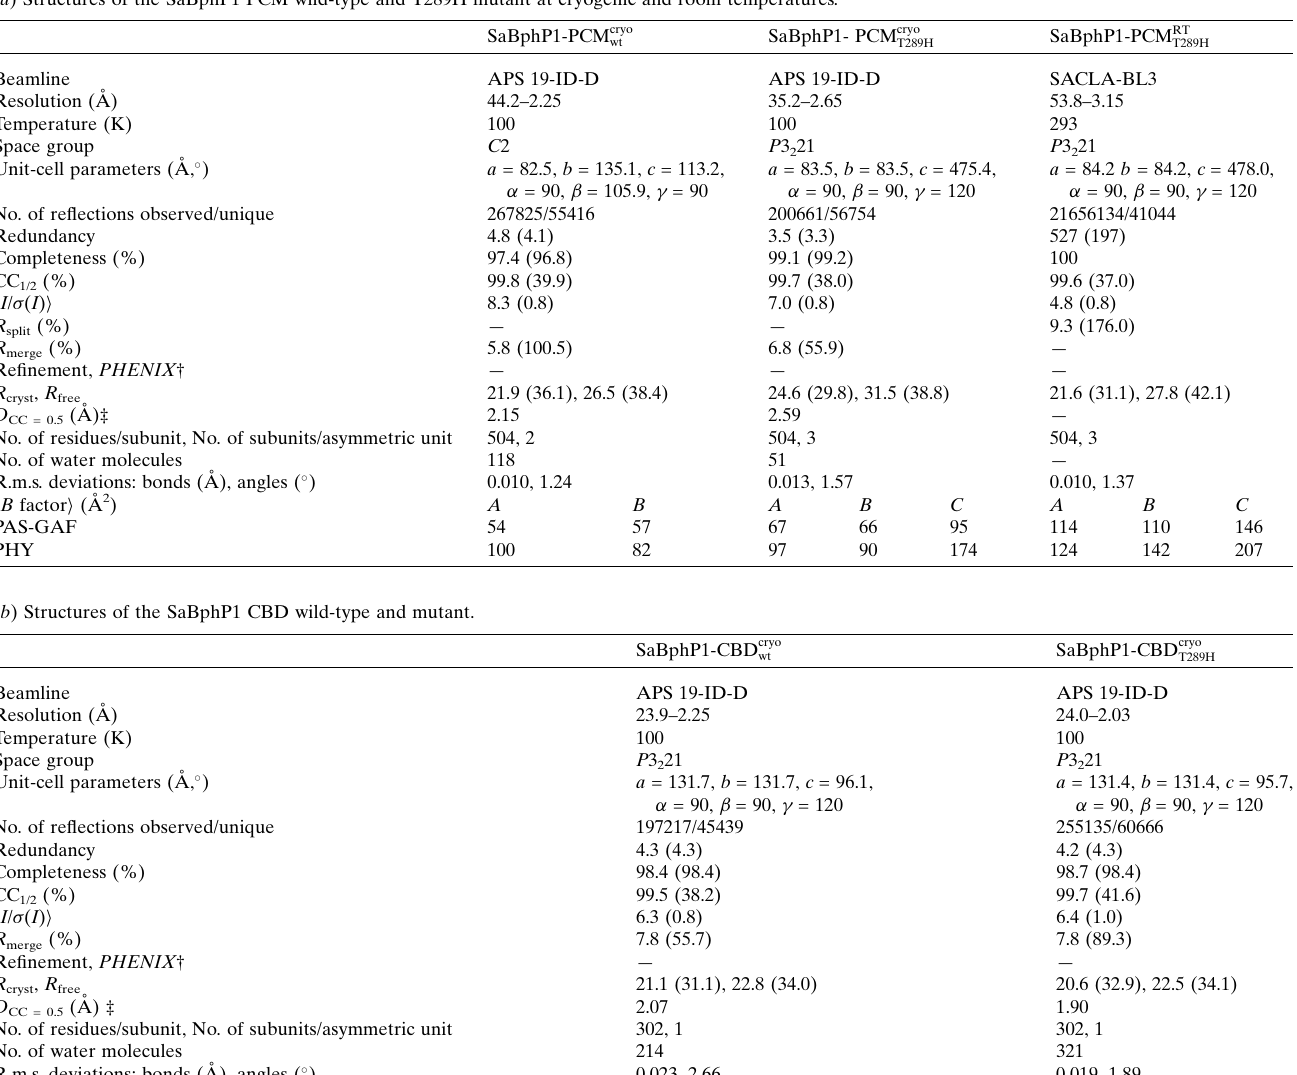
Table 1 Data collection and refinement statistics for ( a ) the SaBphP1-PCM and ( b ) the CBD constructs. The data in the highest resolution shell are given in parentheses. Resolution limit is estimated from CC 1/2 > 1/e (36.8%). The D CC = 0.5 indicates that there is information in the data beyond our chosen resolution limit. ( a ) Structures of the SaBphP1 PCM wild-type and T289H mutant at cryogenic and room temperatures.